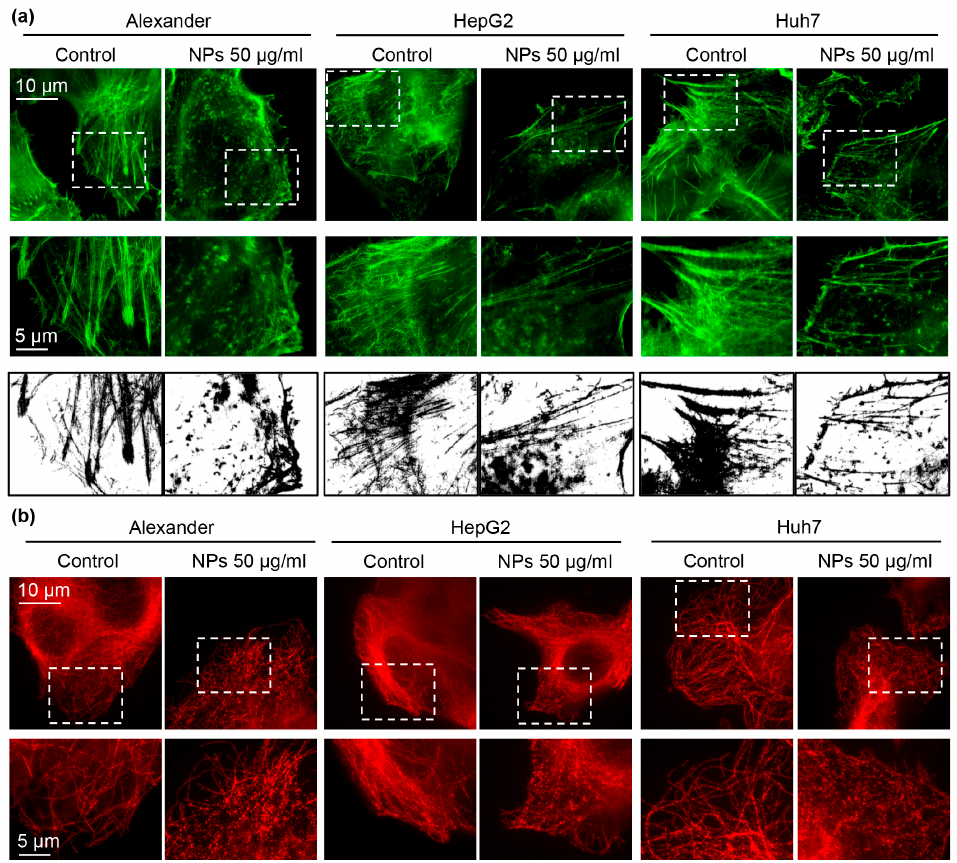
Figure 4. Cytoskeleton remodeling under NP treatment. ( a ) IXplore SpinSR Olympus super-resolution microscopy of F-actin staining (green). Cells were treated for 24 h with nanoparticles 50 µ g Fe mL − 1 , fixed and stained for F-actin. Binarization was done using ImageJ software. ( b ) Cells were treated with NPs as in a. After the treatment cells were fixed and stained for tubulin (red). Super-resolution imaging was done using IXplore SpinSR Olympus super-resolution system.